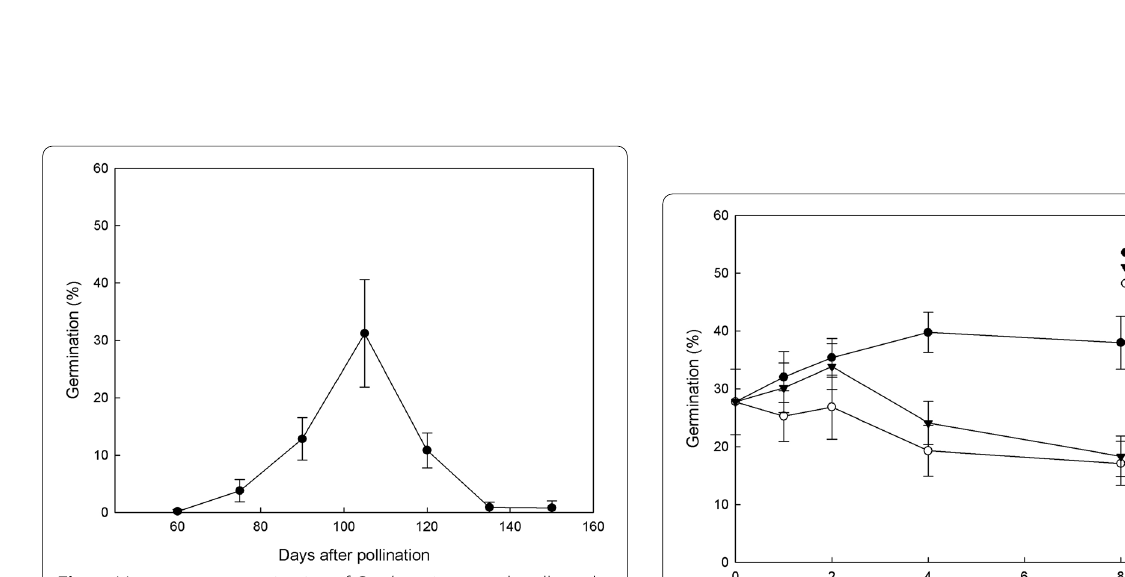
Fig. 3 Seed germination and seedling development of C. subtropicum . A Mature seeds. Scale bar coat rupture. Scale bar 2 mm. C The protocorms have enlarged, and shoot tips are apparent. Scale bar = roots protrude and grow quickly. Scale bar 3 mm. E Shoot buds with numerous developing roots after 4 months of culture. Scale bar = After removal from the flasks, the shoot buds are elongated with expanding leaves. Scale bar